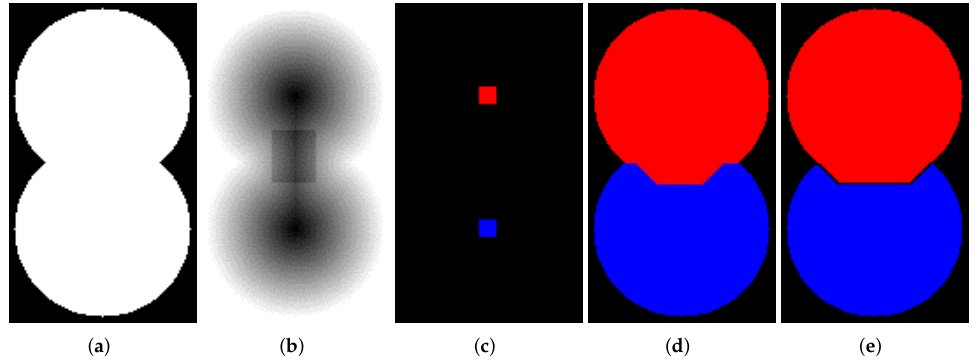
Figure 2. ( a ) Two overlapping binary discs; ( b ) relief; ( c ) initial markers; ( d ) segmentation result without watershed lines (WL) construction; ( e ) segmentation result with WL